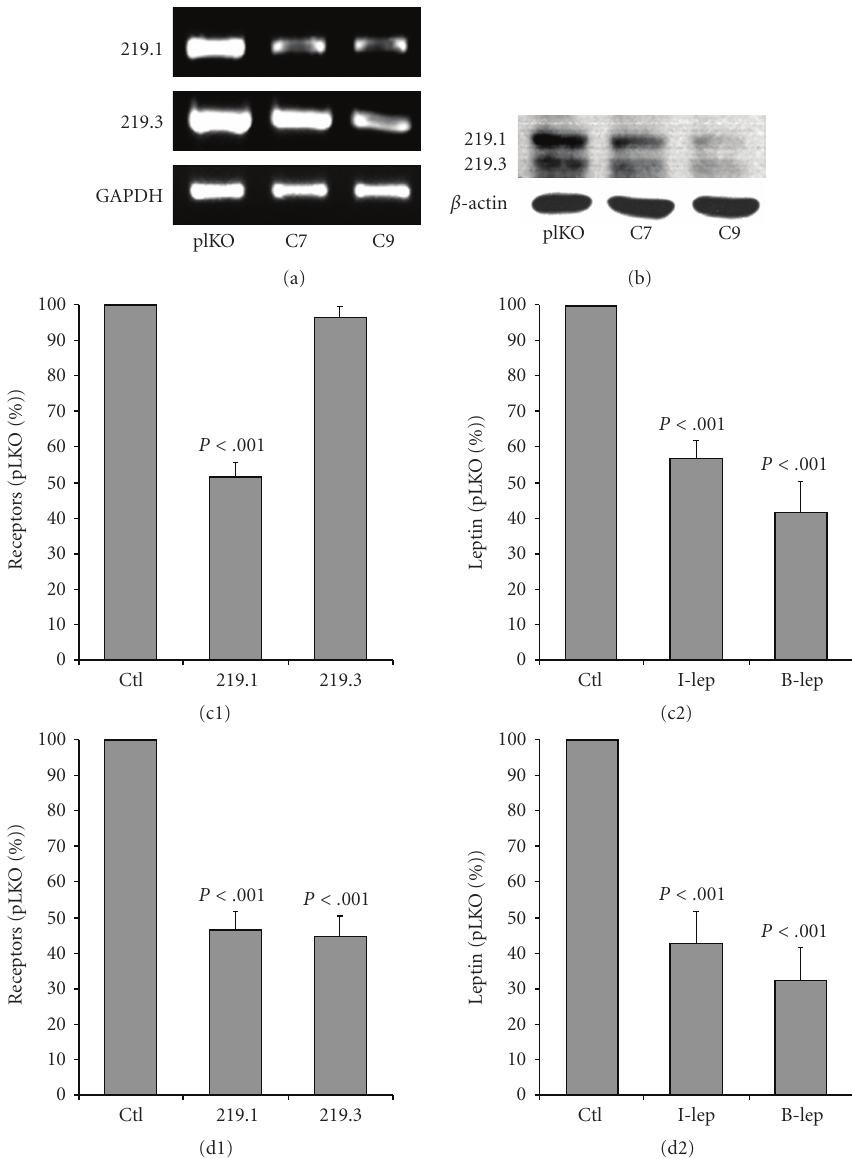
Figure 4: Transcytosis of leptin in knockdown cells . Cells were infected with lentiviruses containing plKO.1, C7, or C9 shRNA. Leptin was added to the apical medium of C7 and C9 infected cells and leptin intracellular content (I-Lep) as well as leptin concentrations in the basal medium (B-Lep) were assessed. Results of the invalidations on the long (219.1) and short (219.3) isoforms were analyzed by RT-PCR (a) and Western blot (b). (c) Infection with the C7-virus decreased expression of the long isoform ( − 48%) (c1) without a ff ecting significantly the short one, and decreased I-Lep ( − 43%) and B-Lep ( − 58%) (c2). (d) C9-virus decreased both long and short isoforms, respectively by 47% and 45% (d1), and decreased I-Lep ( − 57%) and B-Lep ( − 68%) (d2). Bars represent the mean value ± s.e.m of 6 independent